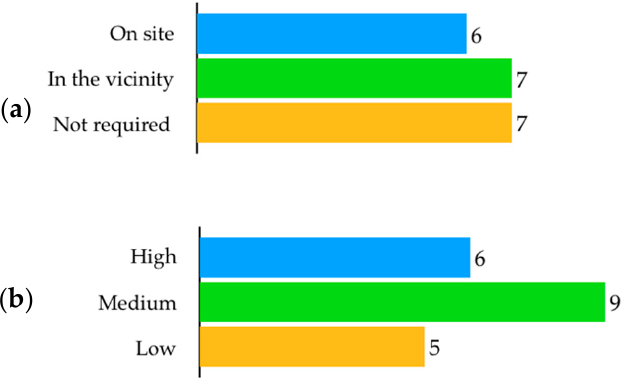
Figure 6. Number of proposed wellness and spa/medical facilities regarding ( a ) the need for and availability of accommodation, and ( b ) seasonal sensitivity.